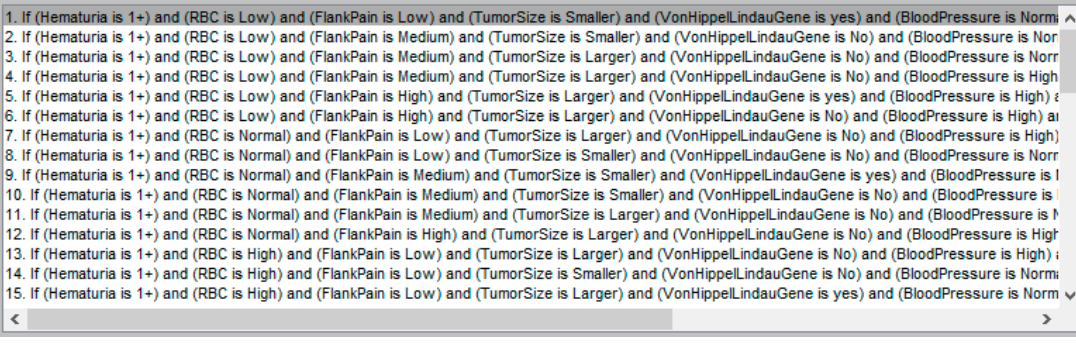
Figure 8. Rules used at layer 2 of proposed systems.